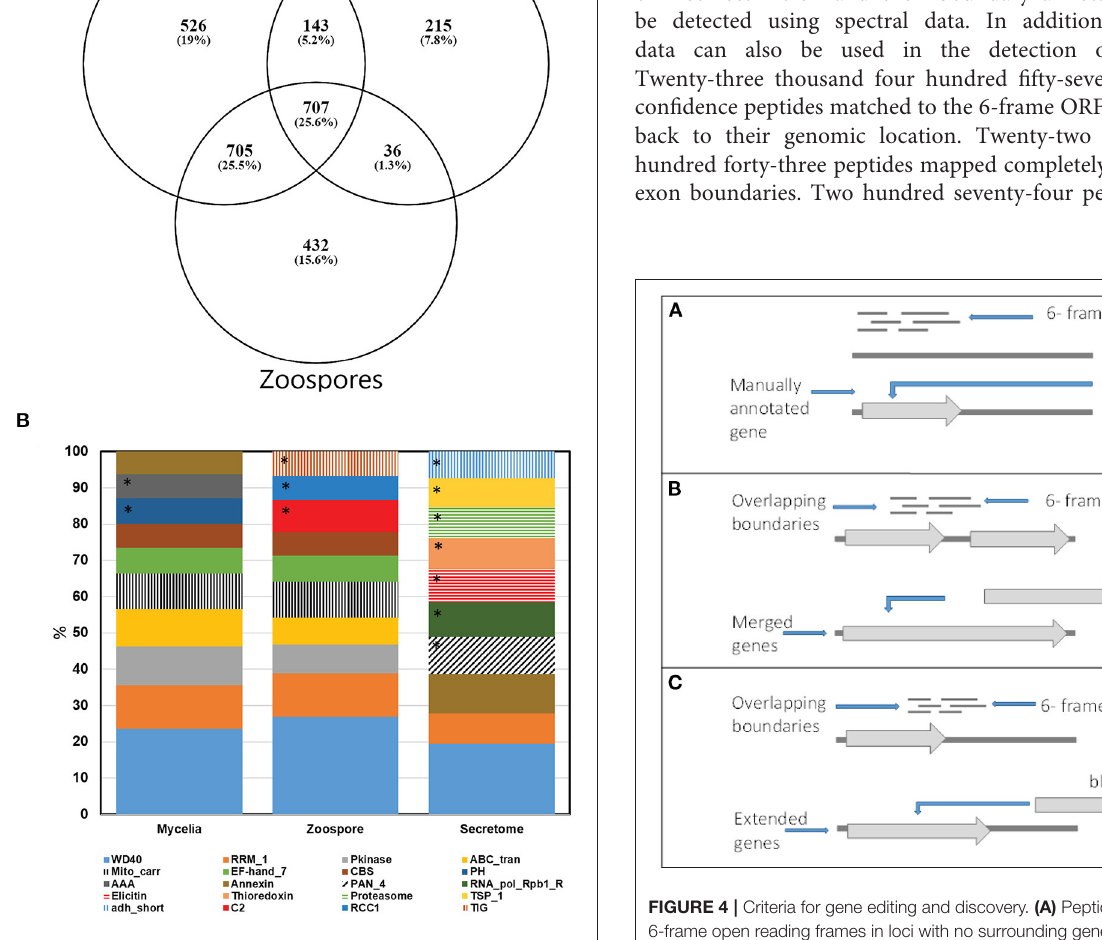
FIGURE 3 | (A) Number of proteins detected by mass spectrometry of each sub-proteome supported by at least two 95% confident peptides. (B) Top 10 PFAM domains based on the number of proteins identified in each sub-proteomes. *Represent unique domains to each sub-proteome. For a complete PFAM assignment, refer to Supplementary Material 1 .